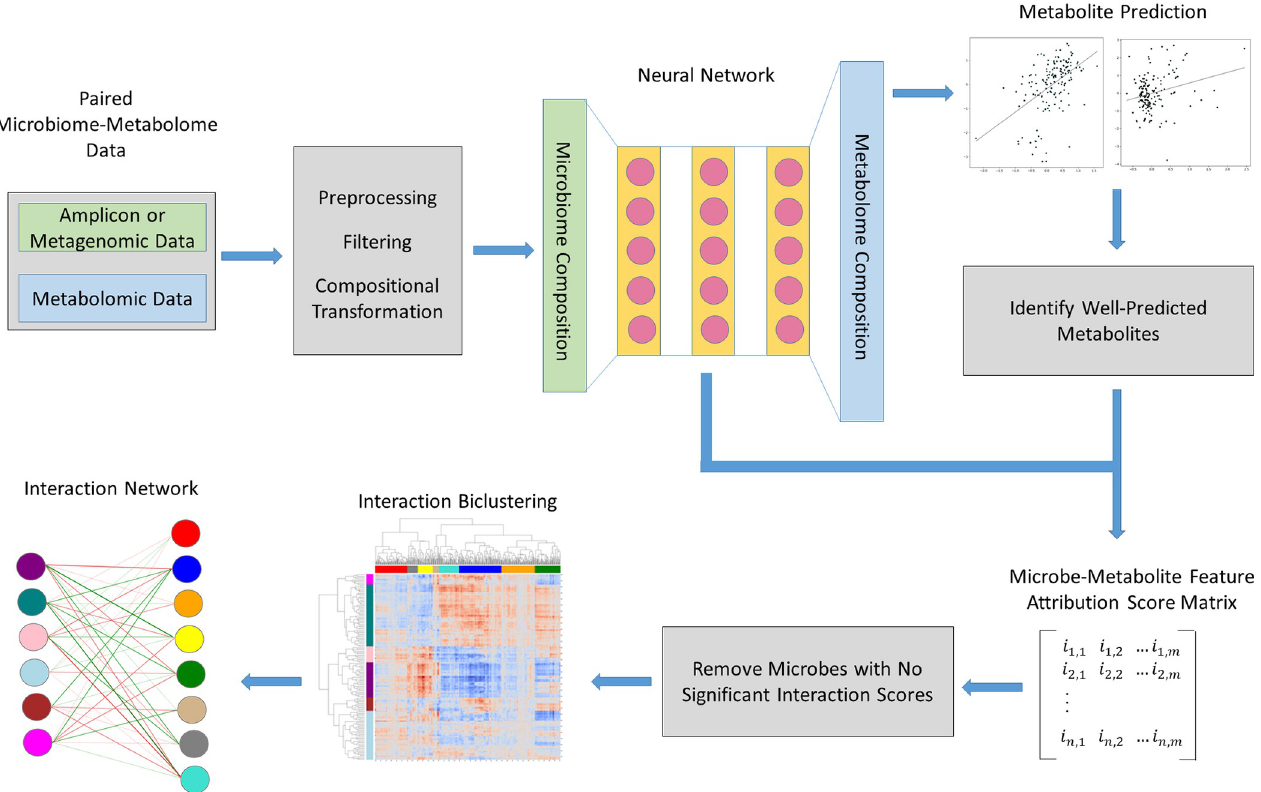
Fig 1. Framework of MiMeNet learning model. MiMeNet uses paired microbiome and metabolome data for model training. Microbiome abundance features (green) are used to train a neural network to predict metabolite abundance features (blue). Well-predicted metabolites are identified, and the trained models are used to learn a microbe-metabolite attribution score matrix. The attribution score matrix is biclustered into microbe and metabolite modules which are then used to construct a module-based interaction network.